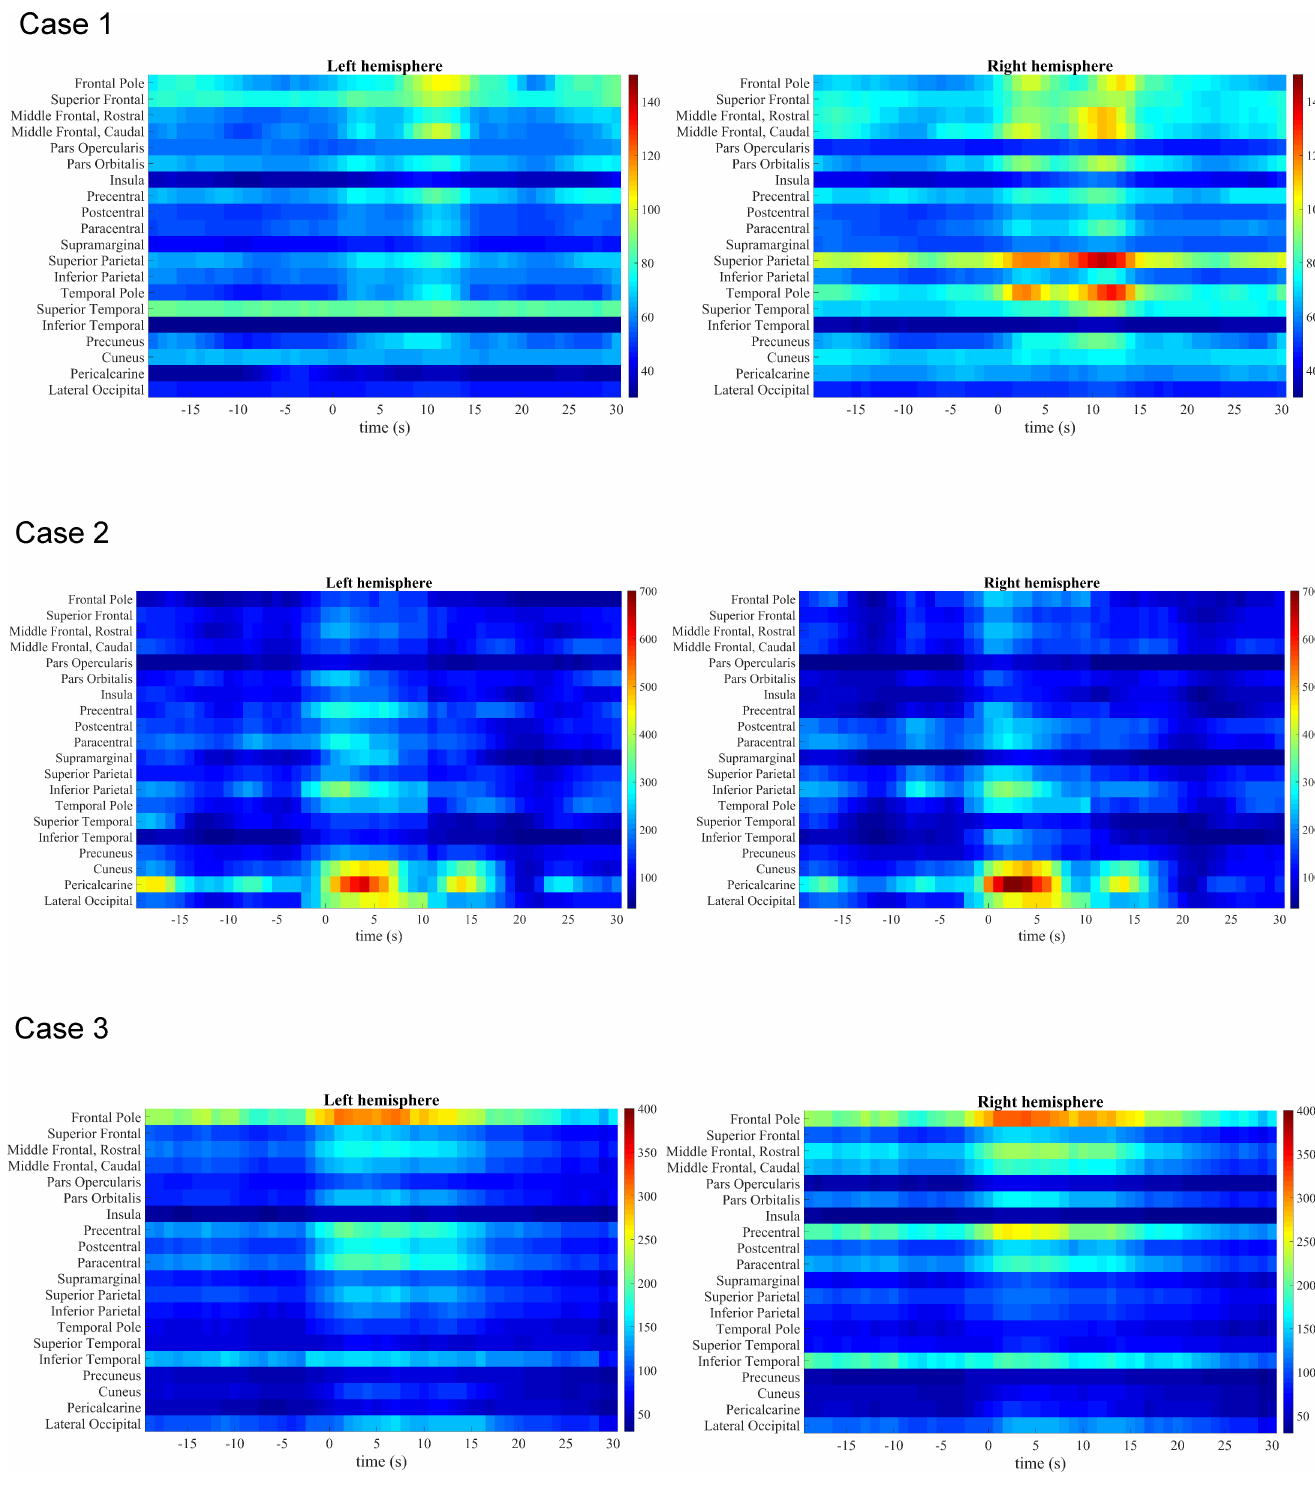
Fig 5. Mean FCD across atlas based regions in epileptic patients. Mean FCD across time (-20 to 30 s) for cortical regions as defined by the Freesurfer atlas. The 0 s indicates the IED onset.